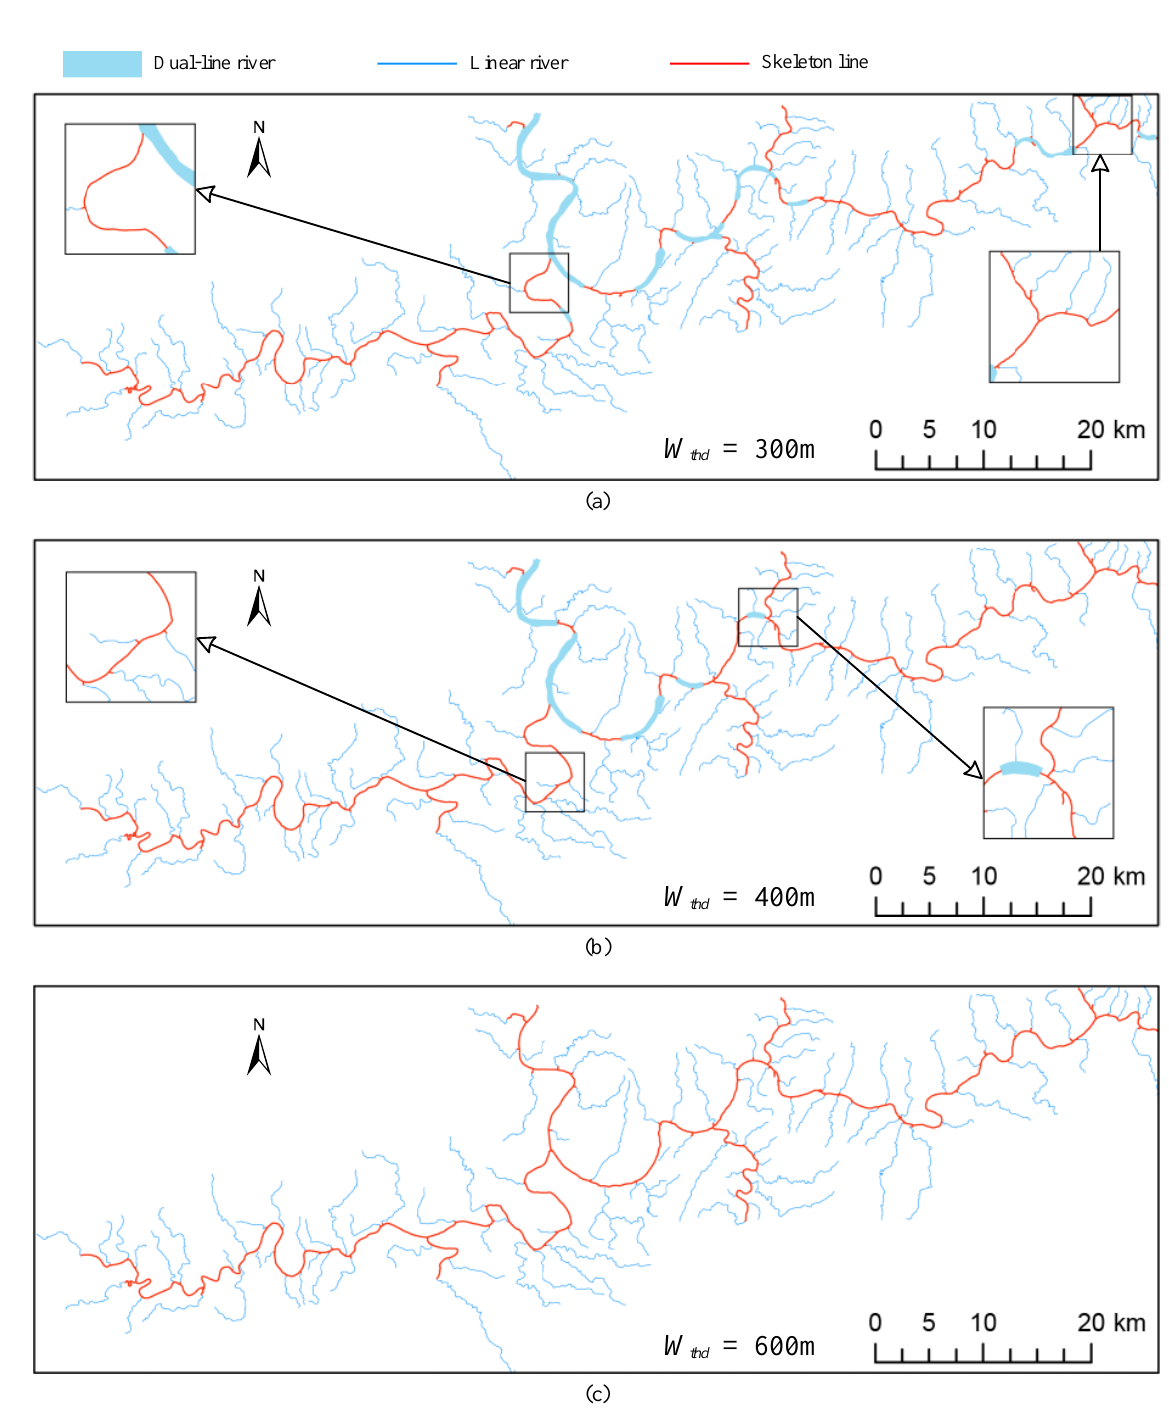
W ; ( b ) = 40 0 m W ; t hd t hd